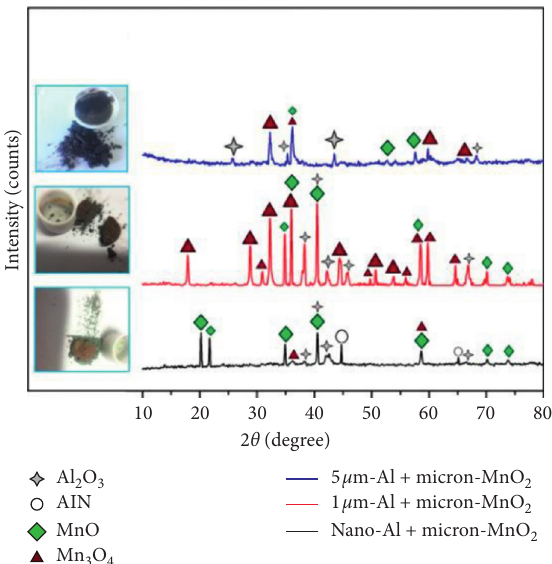
Figure 7: XRD pattern of the reaction products.